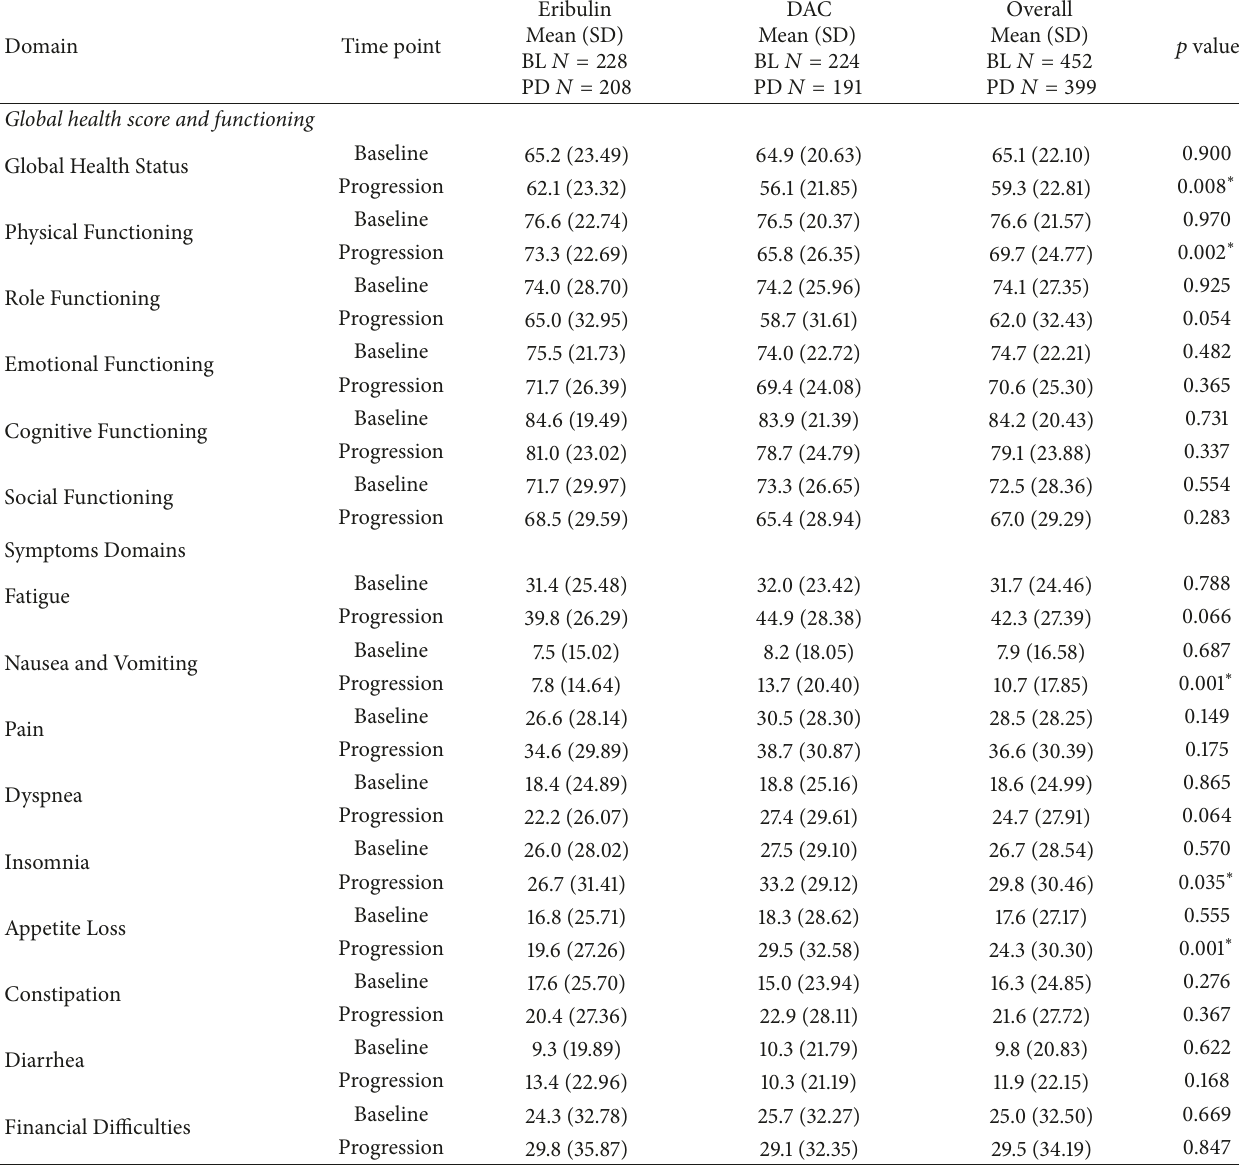
Table 2: Adjusted mean values at baseline and progression stratified by